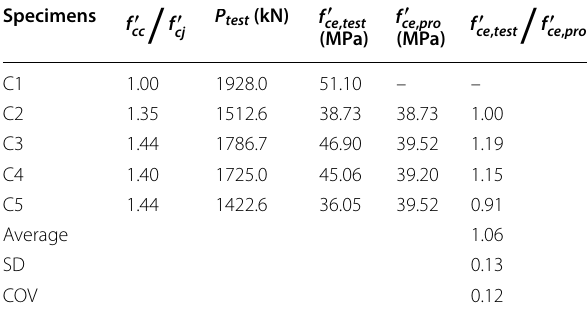
Table 2 Summary of test and analysis results.